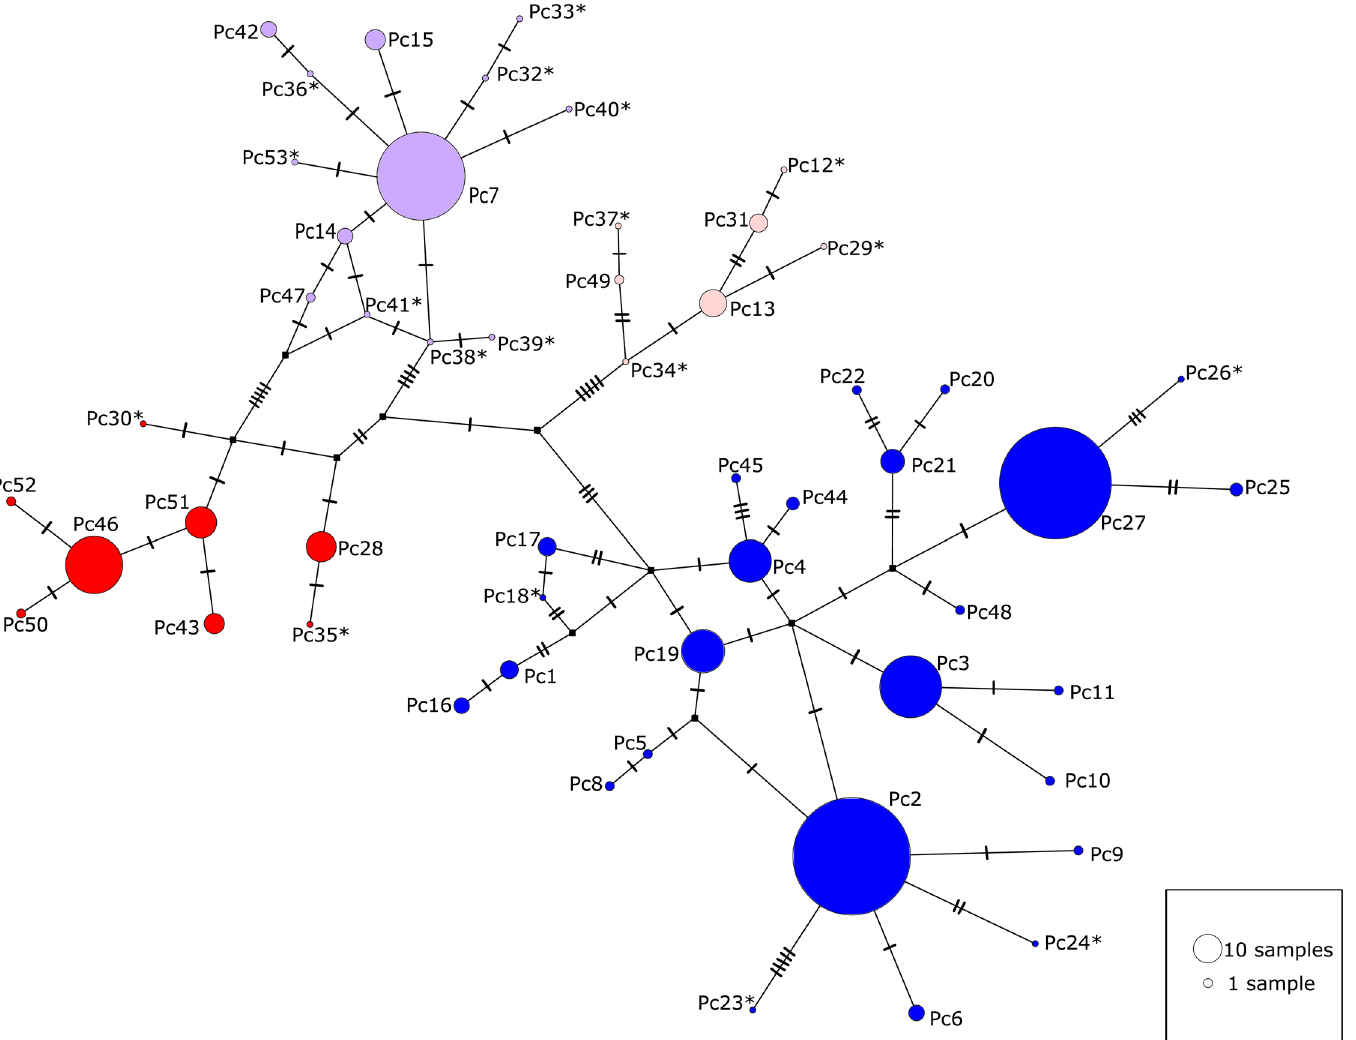
Fig 4. Haplotype network for koala mitochondrial DNA Control Region haplotypes. The size of the circles are proportional to the number of individuals represented. * denotes haplotypes obtained from GenBank (and not detected in our study), which are represented by a single individual. Squares represent unsampled hypothesised haplotypes. Crosses on connecting lines indicate the number of mutational steps between haplotypes. Red = northern lineage 1, light red = northern lineage 2, purple = central lineage, blue = southern